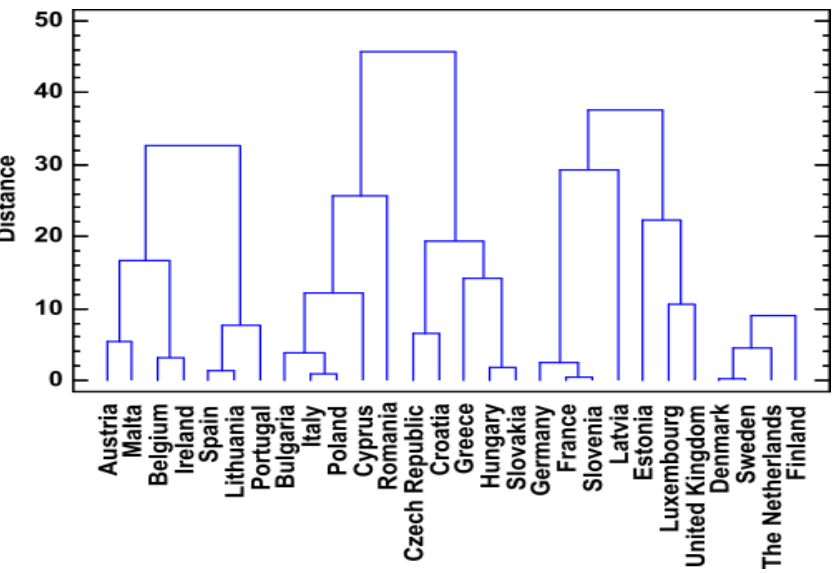
Figure 2. Ward’s dendrogram for the EU-28 Member States in 2015. Source: Our own study.